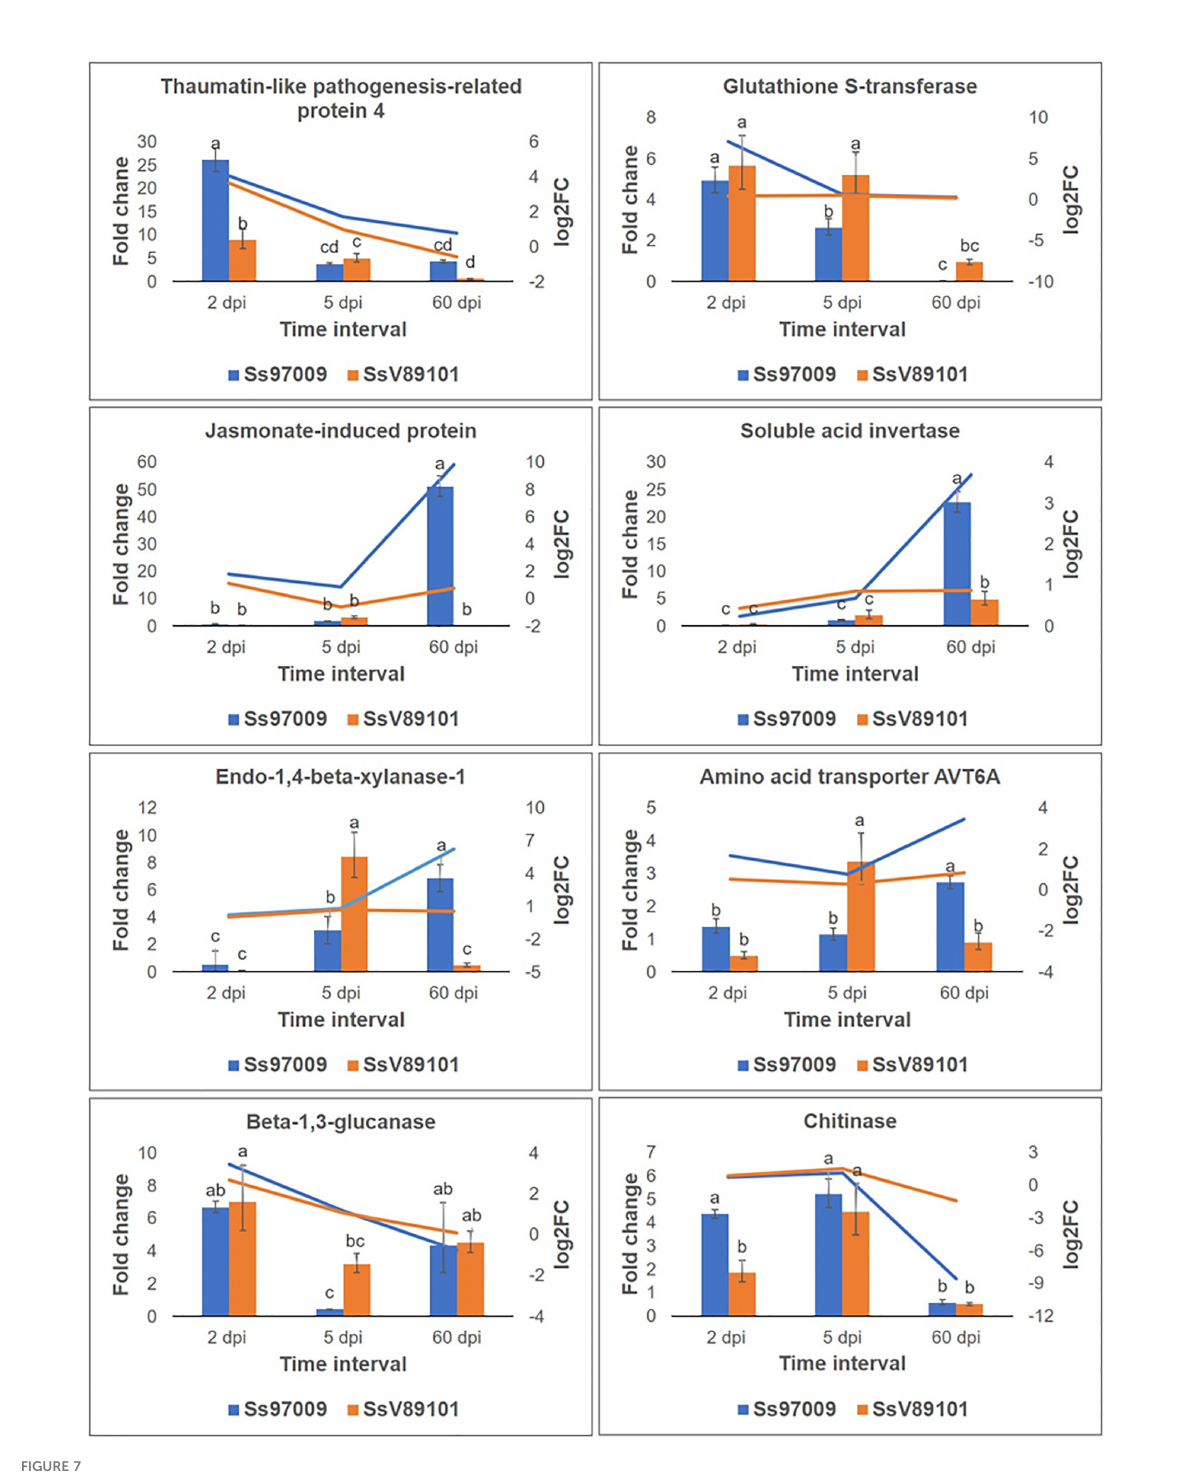
FIGURE 7 Validation of differentially expressed genes identi fi ed in Illumina sequencing by qPCR. Genes selected for validation include thaumatin-like pathogenesis-related protein 4; glutathione S-transferase; jasmonate-induced protein; soluble acid invertase; endo-1,4-beta-xylanase-1 like; amino acid transporter AVT6A; beta-1,3-glucanase; and chitinase. The x-axis represents the sugarcane buds inoculated with the S. scitamineum isolates Ss97009 and SsV89101 sampled at different intervals: 2 dpi, 5 dpi, and 60 dpi, the y-axis (left) represents the fold change calculated by qPCR using elongation factor a (eEF1 a ) gene as the reference gene, and the y-axis (right) represents the log2 fold change values obtained from Illumina sequencing. Error bars represent the standard deviation based on three biological replicates. Different small case letters over the error bars represent that they are signi fi cantly different (Tukey ’ s test, P ≤